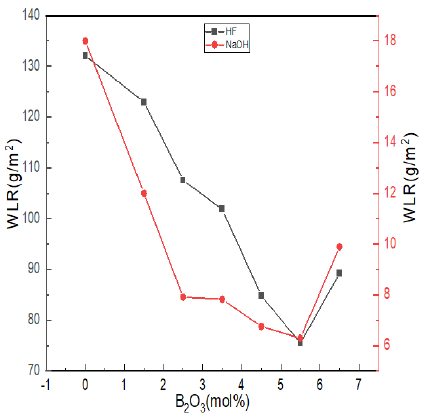
Figure 8. Chemical stability curves of Li 2 O − Al 2 O 3 − SiO 2 series glass with different B 2 O 3 contents.